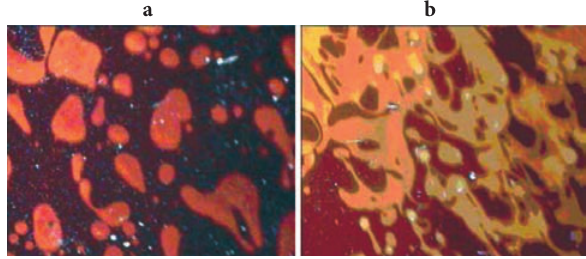
Fig. 7. The stereo microscope image for: a – 5.5 ‰; b – 7.0 ‰ polypropylene modified specimens